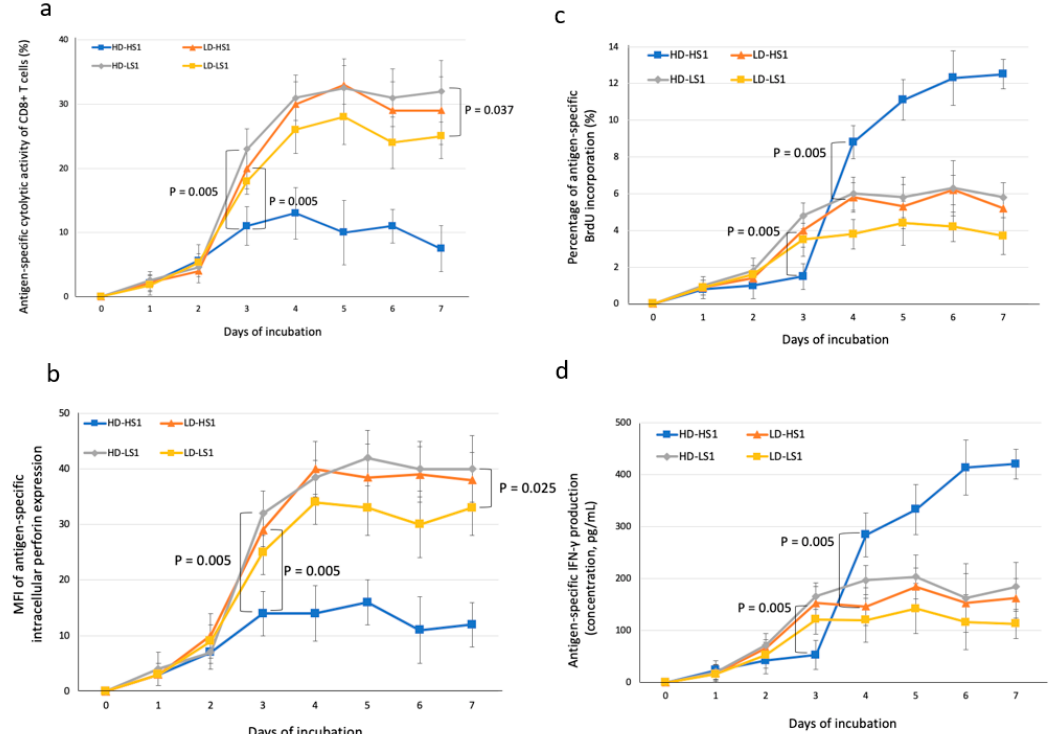
Figure 2. Kinetics of dendritic cells (DC)-elicited spike-specific CD8+ T cell responses to the purified recombinant receptor-binding domain (RBD)-containing S1 subunits (HS1: S1 of highly pathogenic SARS-CoV-2; LS1: S1 of low pathogenic HCoV-HKU1) with nearly equivalent numbers of molecules. ( a ) Cytotoxic activity (assessed by LDH-releasing cytotoxicity assay); ( b ) Mean fluorescein intensity (MFI) of intracellular perforin expression (stained with FITC-conjugated δ G9 and assessed by flow cytometry); ( c ) Lymphoproliferation responses (assessed by BrdU incorporation assay); ( d ) IFN- γ production in cell culture supernatants (assessed by ELISA). Data are presented as mean + SD among 10 subjects. High dose (HD) and low dose (LD) of individual antigens as following: LD-LS1 as 120 ng/mL and HD-LS1 as 600 ng/mL; LD-HS1 as 110 ng/mL and HD-HS1 as 550 ng/mL, to achieve the nearly equivalent numbers of protein molecules; p -values were determined by Wilcoxon signed-rank